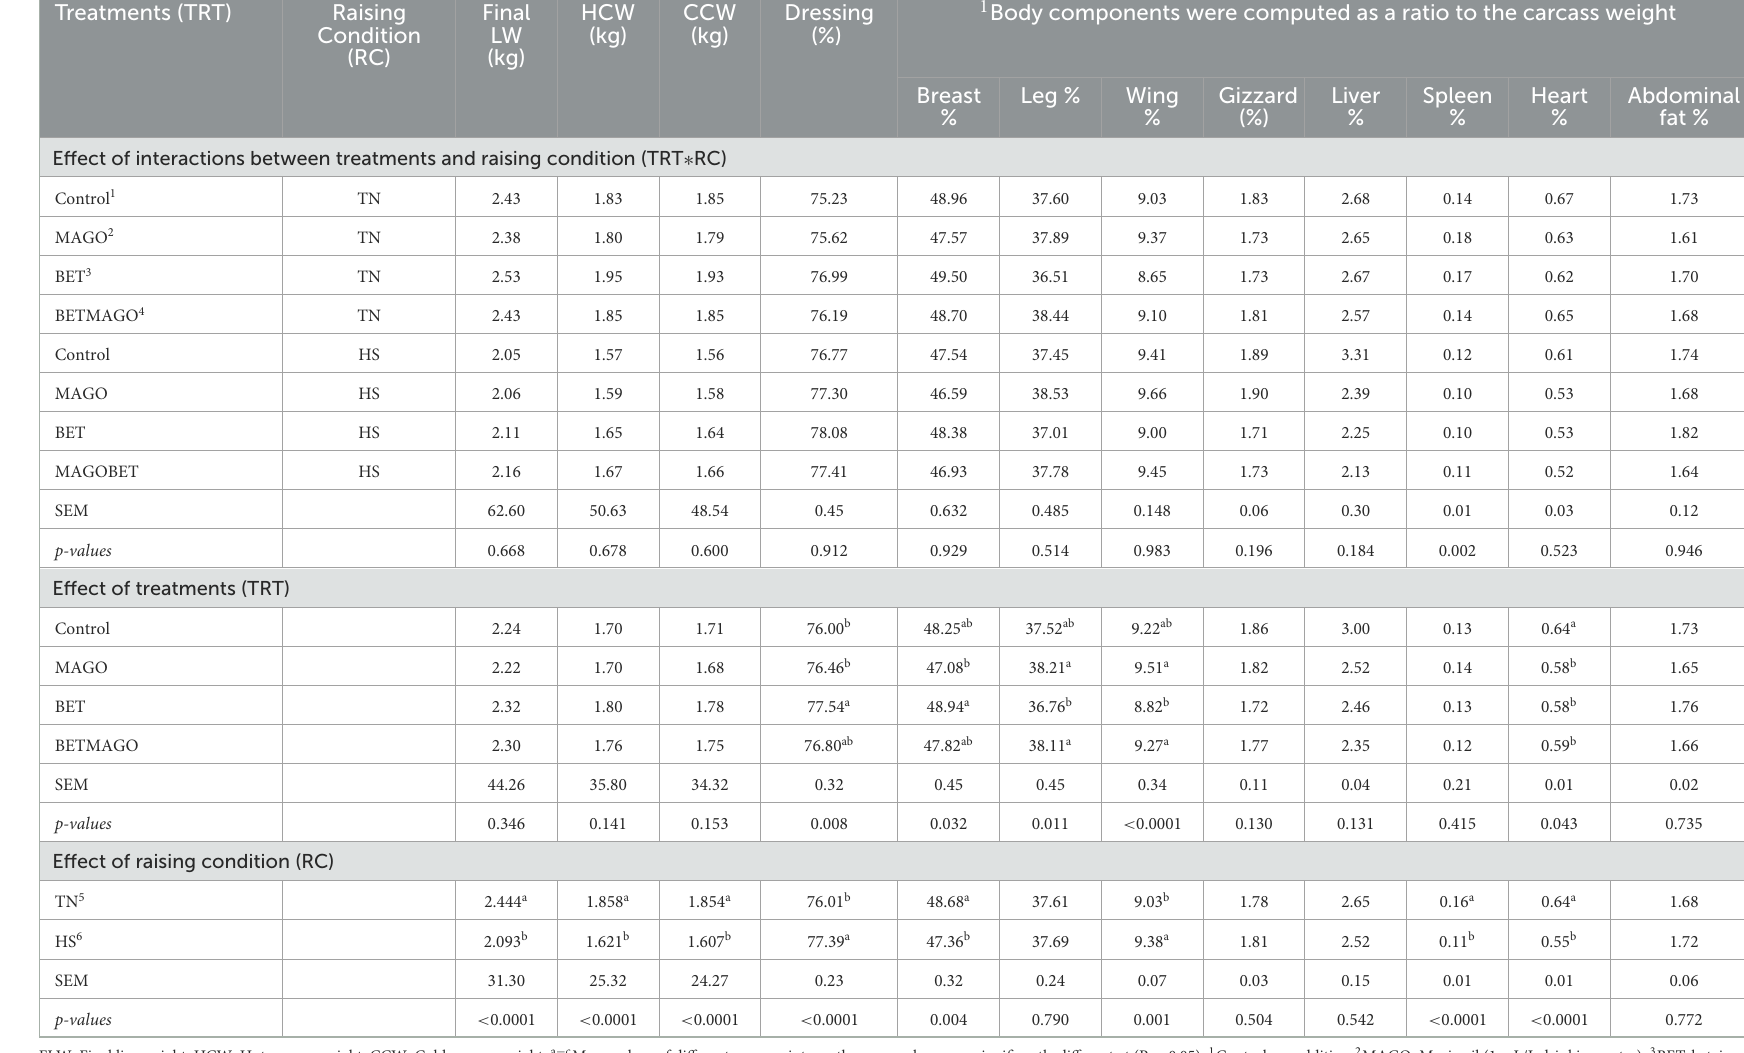
TABLE 2 Effect of the treatments on carcass characteristics and body components of broiler chickens at d 35 under thermoneutral (TN) and heat stress (HS) raising conditions. Treatments (TRT) Raising